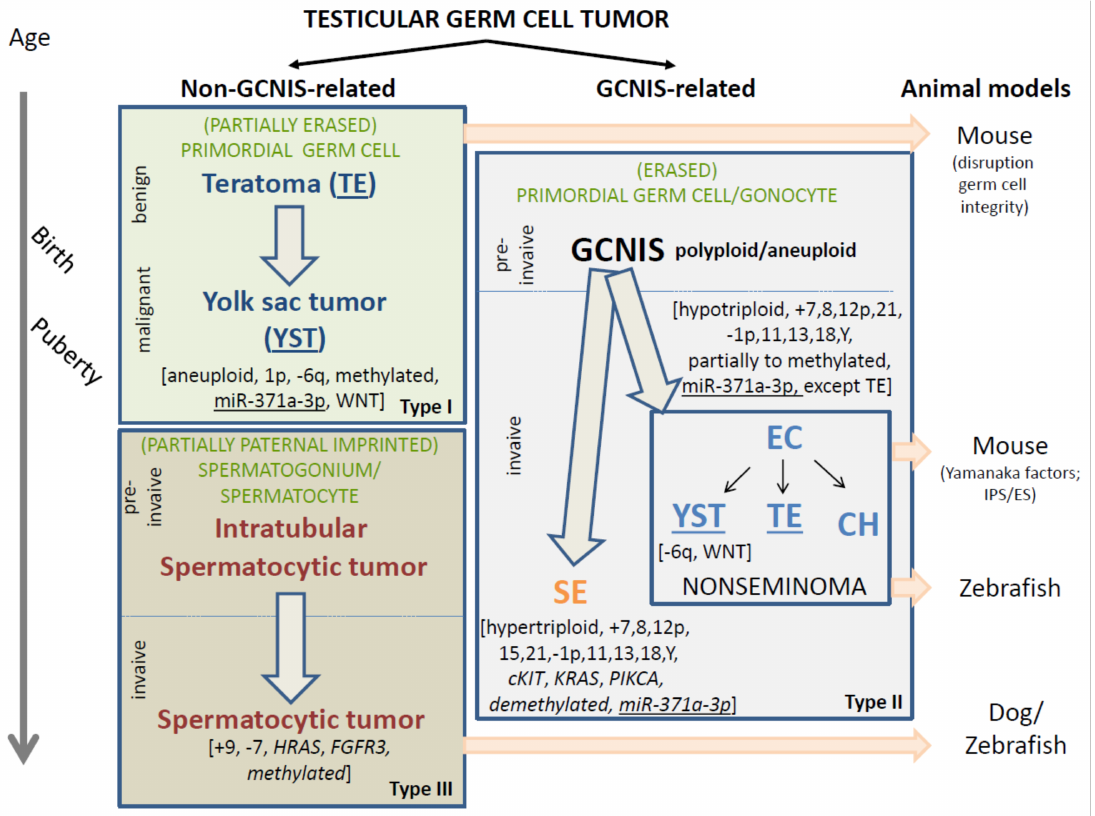
Figure 1. Schematic representation of the various entities of testicular germ cell tumors (GCTs). The time line is indicated on the left side and the proposed animal models on the right. The GCTs include the non-GCNIS (germ cell neoplasia in situ) related GCTs (left panel) and GCNIS-related GCTs (right panel). The non-GCNIS related GCTs are subcategorized into the prepubertal teratomas (TE) and yolk sac tumors (YST) as well as the spermatocytic tumors. These are also referred to as Type I and III, respectively. The GCNIS-related GCTs are histologically (and clinically) subdivided into the seminomas (SE) and the various elements of nonseminomatous GCTs, being embryonal carcinoma (EC), YST, choriocarcinoma, and TE. Note the overlapping histology between the prepubertal TE / YST and the TE and YST elements in the GCNIS-related nonseminomas. However, they have a separate (and independent) pathogenesis (see text for further details). The presumed cells of origin are indicated in green, reflecting a (partially and fully erased) primordial germ cell (Type I and II), to partially paternal imprinted spermatogonium / spermatocyte (Type III). The precursors are indicated when known (preinvasive), while specifically the benign and malignant behavior of the pediatric TE and YST is highlighted. In addition, the most prominent and recurrent molecular genetic changes are indicated, of putative interest to be used for molecular pathological approaches. These include total genomic anomalies, like polyploid / aneuploid, specific chromosomal imbalances like losses (-) and gains ( + ), as well as recurrent mutations ( italics ). In addition, the methylation status is indicated as well as the possible use of miR-371a-3p as a liquid biopsy molecular biomarker ( underlined ). All malignant histological elements, independent of age, are identified by this biomarker (except TE). The WNT pathway is specifically involved in the YST components, independent of age and also of